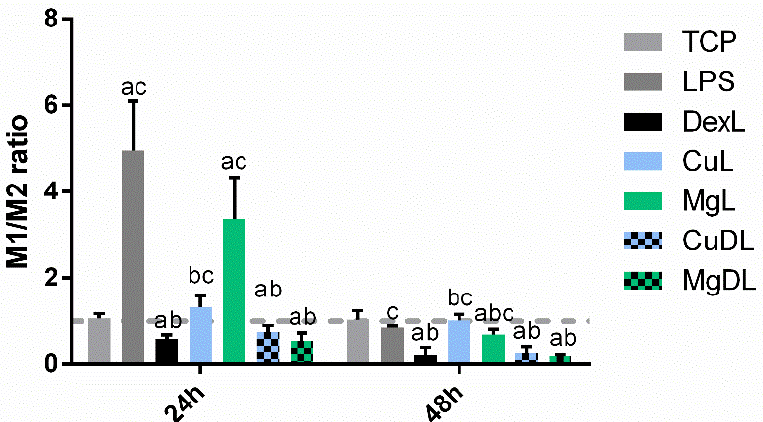
Figure 7. M1/M2 ratio of LPS-activated macrophages stimulated with dex and the combination of dex with Cu 2+ and Mg 2+ . Statistically significant differences compared to TCP, LPS and dex were indicated with a, b or c, respectively ( p < 0.05).